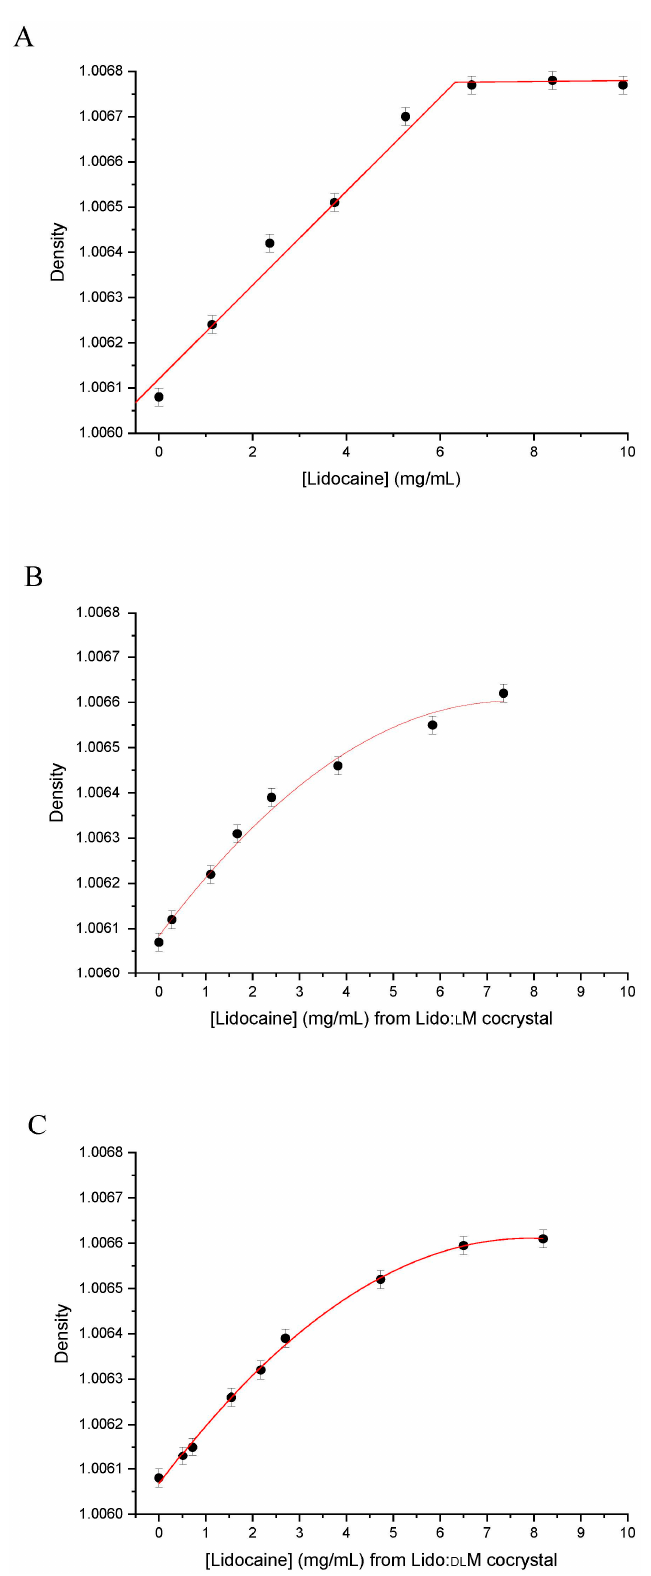
Figure 8. Density measurement as a function of the lidocaine content in lidocaine ( A ); Lido: L M cocrystal ( B ); and Lido: DL M cocrystal ( C ) solubilized in phosphate bu ff er.